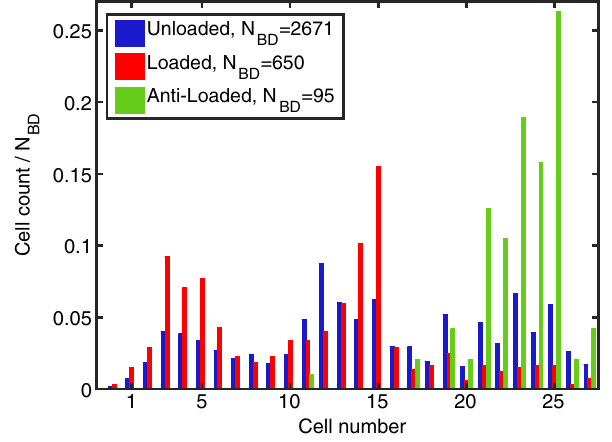
FIG. 6. Breakdown distribution in the unloaded (blue), loaded (red), and antiloaded (green). First and last bars refer to the two coupling